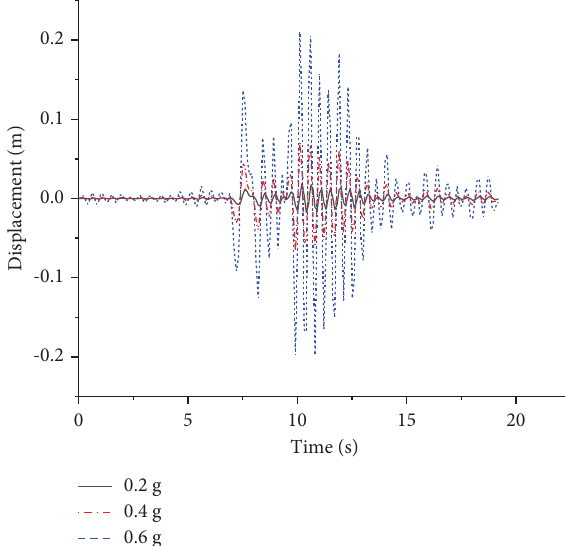
Figure 17: Displacement time-history curves of Tianjin wave under diferent modulated